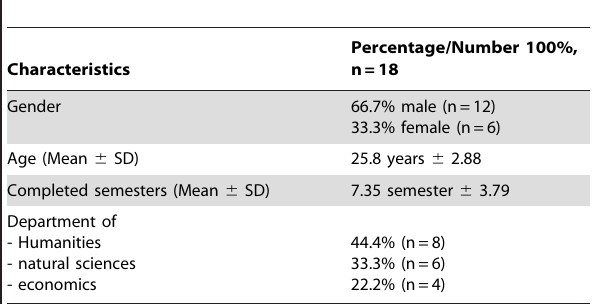
Table 1. Characteristics of participants.